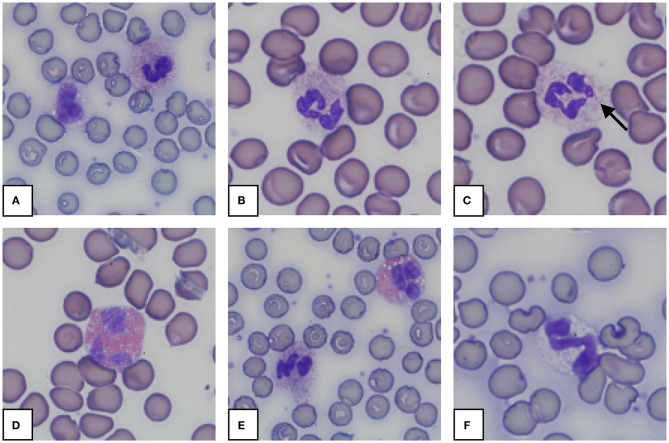
Representative granulocytes in blood smears from an African elephant (Loxodonta africana). (A): Heterophil and normal monocyte; (B): Heterophil; (C): Heterophil with toxic changes (Dohle body, arrow); (D): Eosinophil; (E): Heterophil and eosinophil; (F): Basophil. Wright -Giemsa stain; 1,000x magnification.